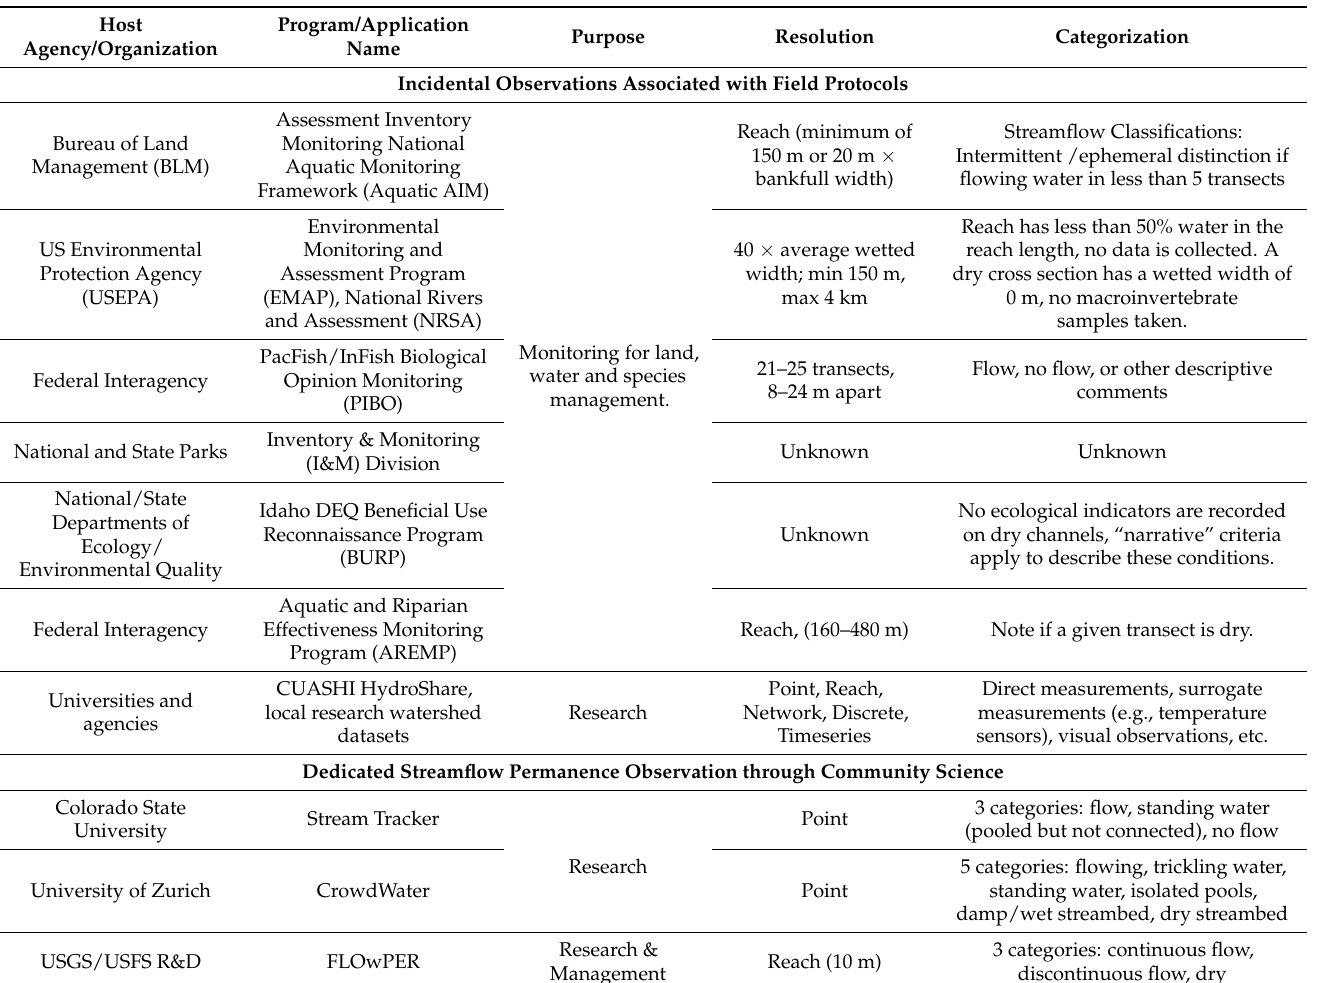
Table 2. Examples of national and regional field surveys that include incidental streamflow permanence data and dedicated streamflow permanence data collection through community science and mobile applications. National and regional surveys include groups, example datasets, data collection purposes, and additional applications. Most states, agencies, and other jurisdictions have more localized monitoring programs that are not listed here. Data collection methods are all visual observations, with the exception of research settings where surrogate measures may be used as a proxy for flow